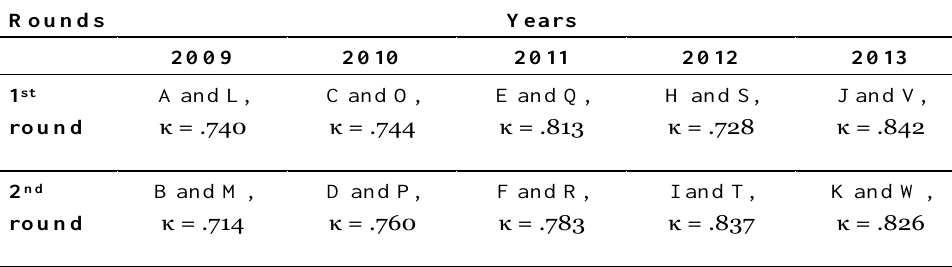
Cohen's Kappa Values for Inter-Coder Reliability